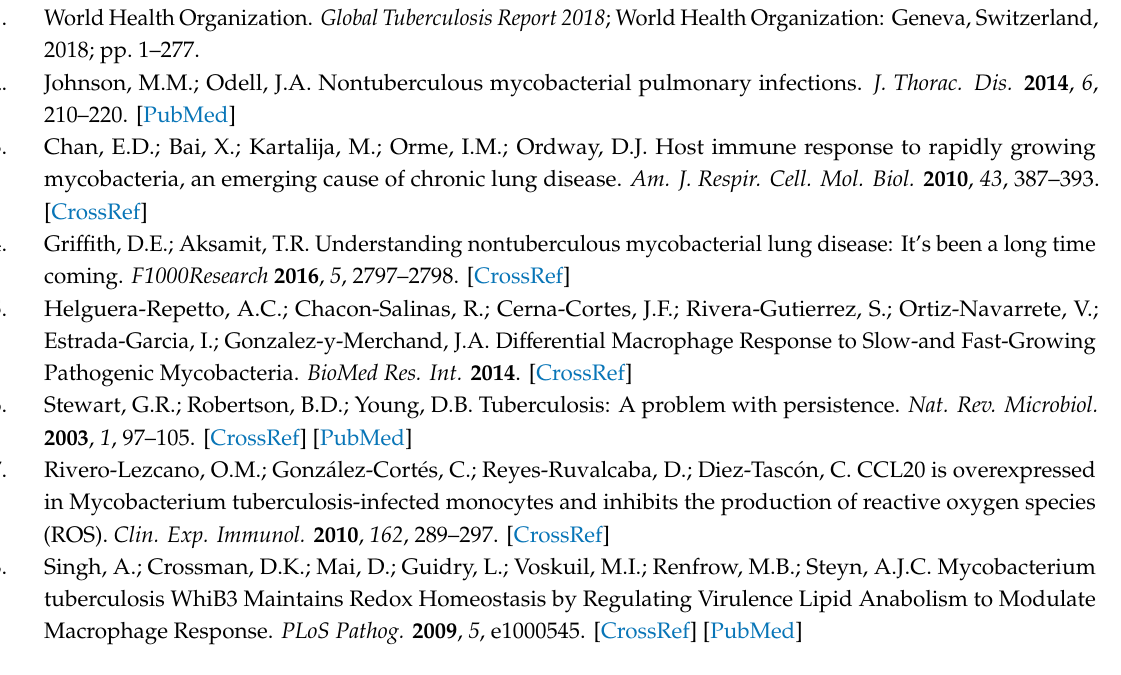
Table S1: Mobile phase gradient and flow as well as wavelengths of the UV detector used to quantify the three drugs by HPLC: potassium phosphate bu ff er (A), methanol (B), ultrapure water (C) and acetonitrile (D), Figure S1: Particle size cumulative undersize distribution evaluated by laser light di ff raction of suspension 1 (circle) and of suspension 2 (square), Figure S2: DSC thermograms of the spray dried powder, Figure S3: X-ray plot of the spray dried